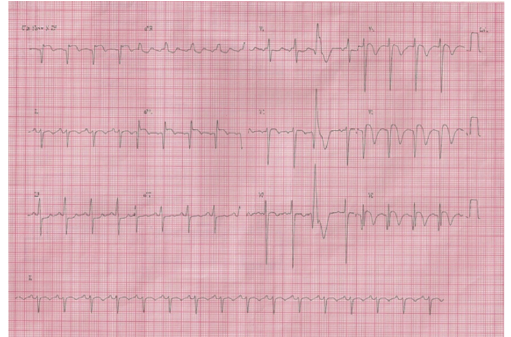
Figure 1: Electrocardiography showing left-axis deviation with ST elevation, T-wave inversion and Q-waves in leads I, aVL, and V5 to V6, compatible with subacute anterolateral myocardial infarction and a single ectopic beat.